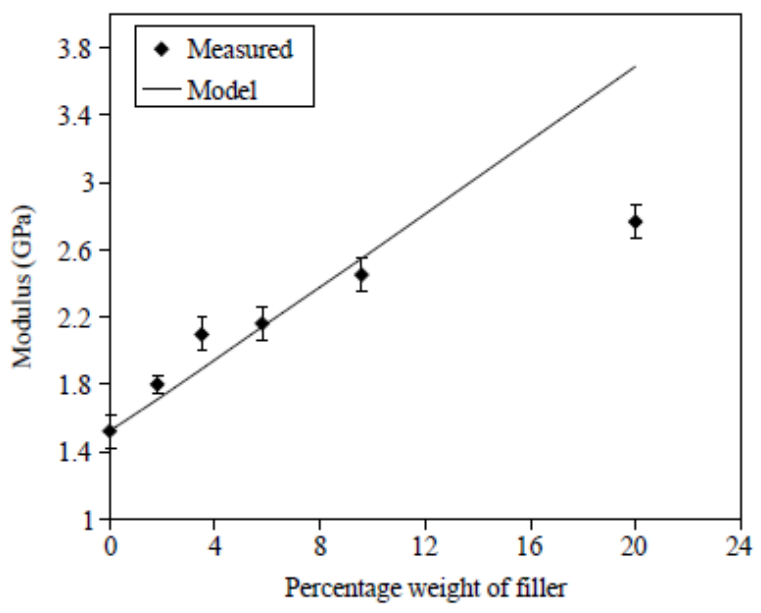
Figure 14. A comparison between measured and model predicted Young’s modulus of PP/CNTs composites. Reproduced with permission from ref.